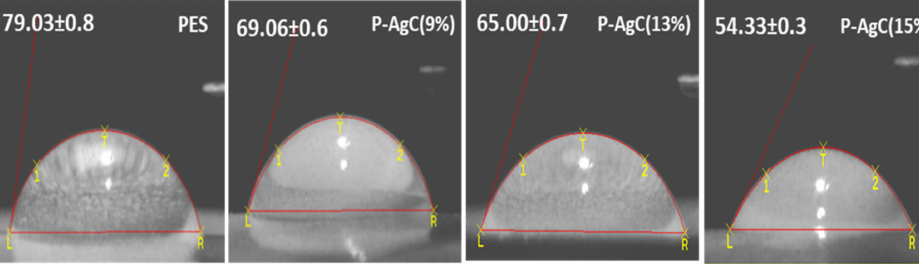
Figure 5. The water contact angle for the neat PES net, P-AgC (9%), P-AgC (13%), and P-AgC (15%) composite